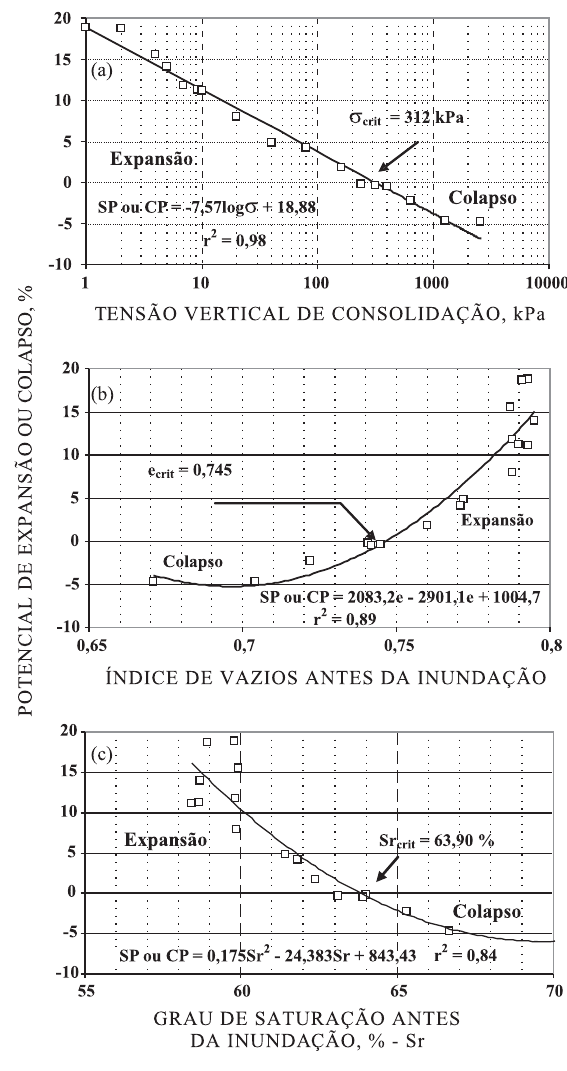
Figura 7. Variação do potencial de expansão ou de colapso obtida nos ensaios edométricos simples: (a) com a tensão vertical de consolidação; (b) com o índice de vazios antes da inundação; (c) com grau de saturação antes da inundação. SP: potencial de expansão; CP: potencial de colapso; e: índice de vazios; Sr: grau de saturação em água; σσσσσ : tensão; r 2 : coeficiente de correlação; crit: